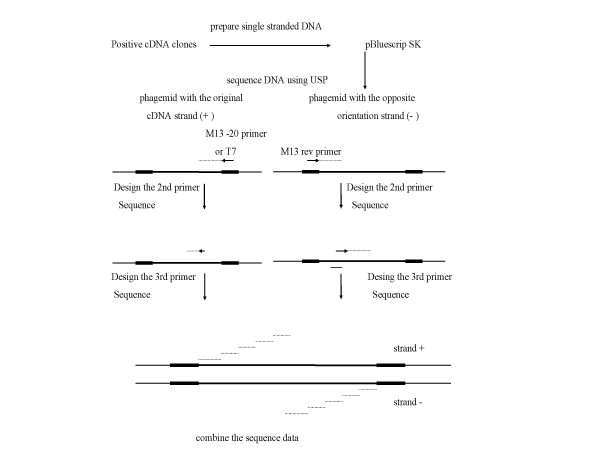
Sequencing strategy of positively identified clones. The insert was first sequenced by the universal primer T7 (or M13 -20 primer) in one orientation and by the universal M13 reverse primer in the reverse orientation. Since the range of sequenced DNA was short (a few hundred base pairs), a sequence from near the end of this run was used to design a second primer, which primed the sequence from this region and moved another few hundred nucleotides further. From the end of this run the third primer was designed and the circle was repeated until the entire insert had been covered.